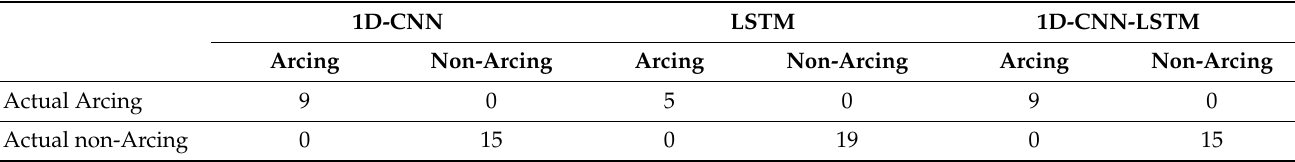
Table 9. Validation Phase Output Matrix: Frequency Domain Arcing Fault Classification.